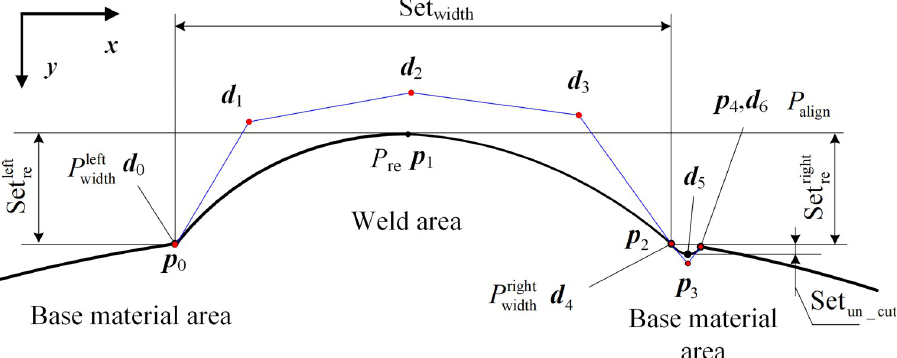
Fig 10. Simulation of weld profile curve with single defect parameter undercut Set un_cut